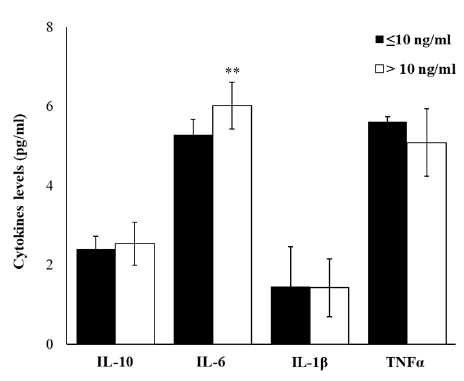
Figure 2. Plasma levels of pro- and anti-inflammatory cytokines. Plasma levels of IL-10, IL-6, IL-1 β , and TNF α in enrolled workers, according to salivary cortisol levels ≤ or > of 10ng / mL. Data are reported as mean ± S.D. ** p -value ≤ 0.01.